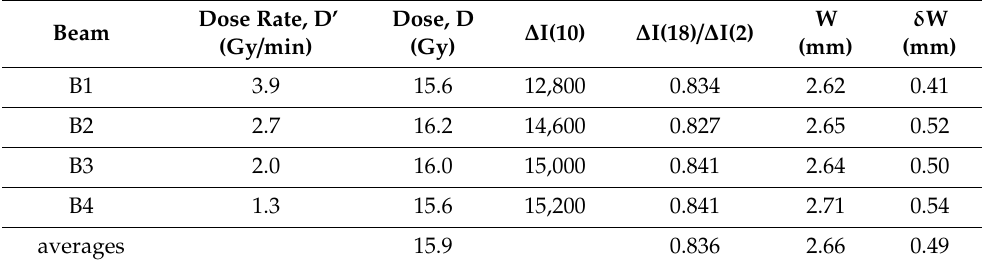
Table 2. The parameters derived from the pixel profile scans in Figure 16, the symbols are defined in the text.